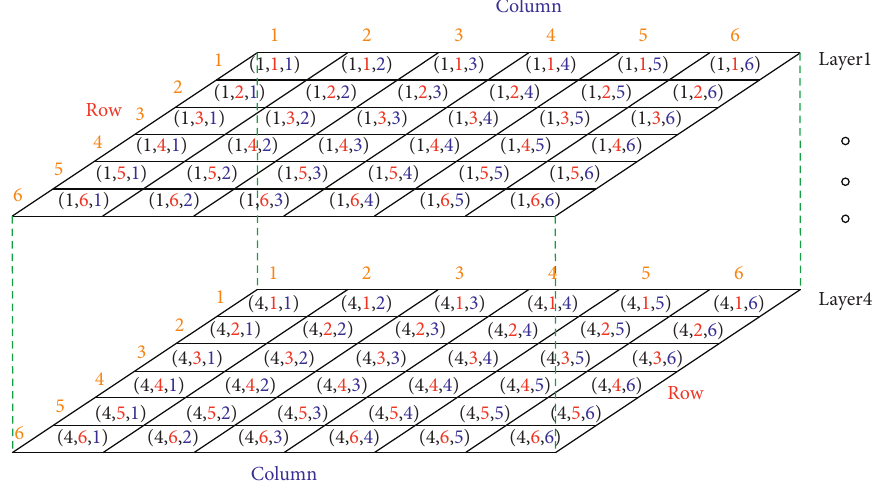
Figure 6: The detailed structure of the observation transform layer 1 in Figure 7 into Figure 8 that is a matrix plot with M rows and M columns. In the same way, the other three layers (layer 2 to 4) in Figure 7 can be trans- formed into their corresponding matrix plots, and the transformed result is omitted here for simplicity. In the matrix plot of Figure 8, each element is a colored dial. The color value (referring to the right color bar) and the size of the colored sector in one rectangle block ( i, j ) ( 1 ≤ i, j ≤ M ) are determined by the initial value corresponding to the same ( i, j ) entry of layer 1 in Figure 7. In Figure 8, the region on the left shows the relatively large color values as well as the size of the colored sectors, while the region on the right shows the relatively small color values as well as the size of the colored sectors. Figure 8 illustrates, from another per-